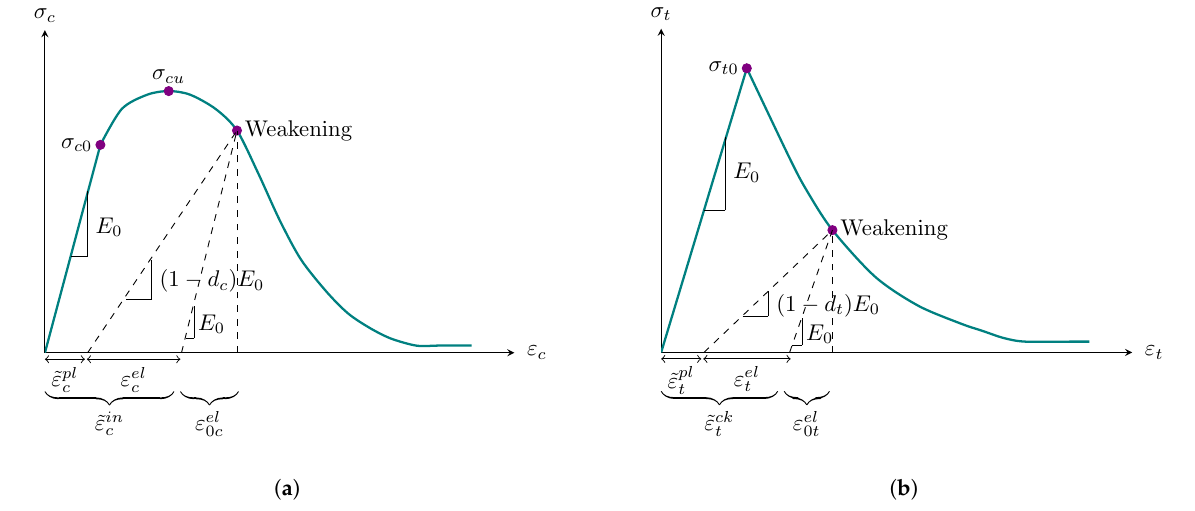
Figure 6. Uniaxial stress–strain relationship: ( a ) compression; ( b ) tension (Abaqus manual [50]). The compressive hardening (˜ ε in ) and tensile cracking (˜ ε ck ) strains are calculated by c t subtracting from the total cumulative strain the elastic strain that relates to intact specimen: